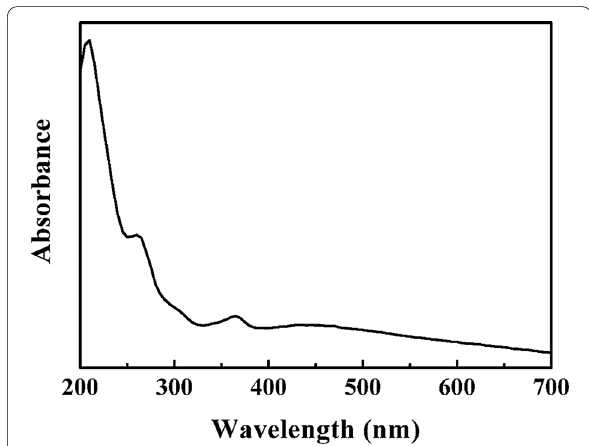
Fig. 5 UV–Vis absorption spectrum of photocatalytic-adsorbent AgZnO/POMs